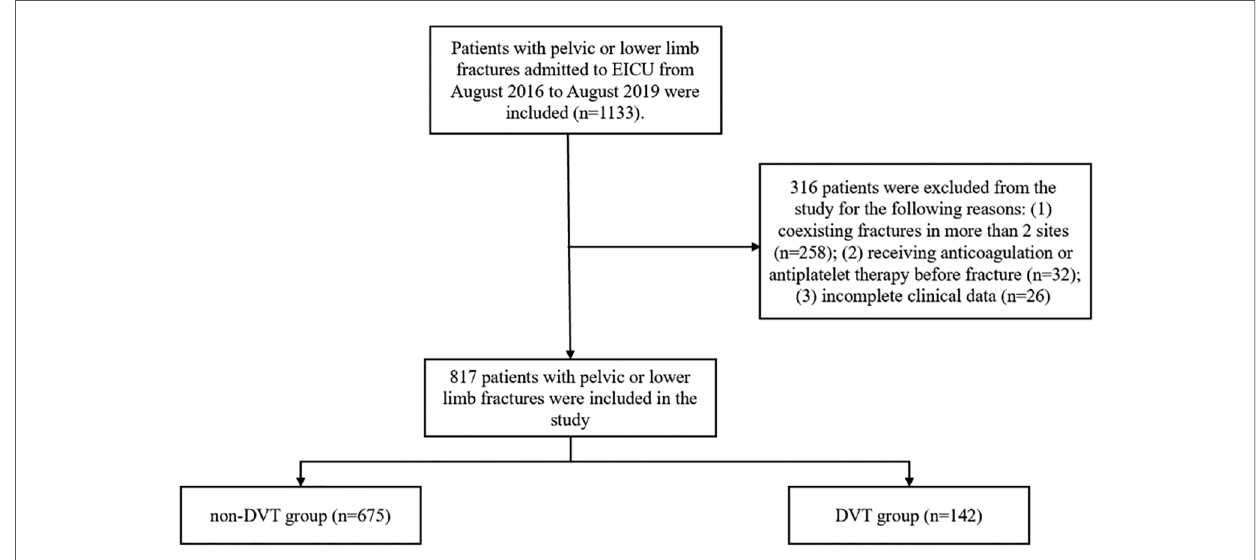
FIGURE 1 Flow diagram of